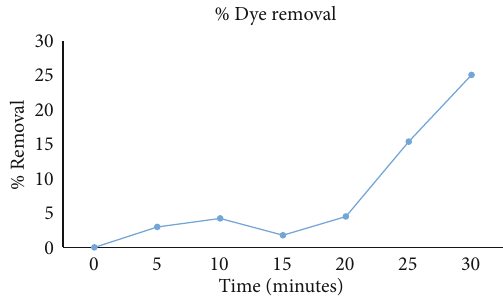
Figure 13: Percentage removal of Azure A dye by surface-modi fi ed ferrospheres.